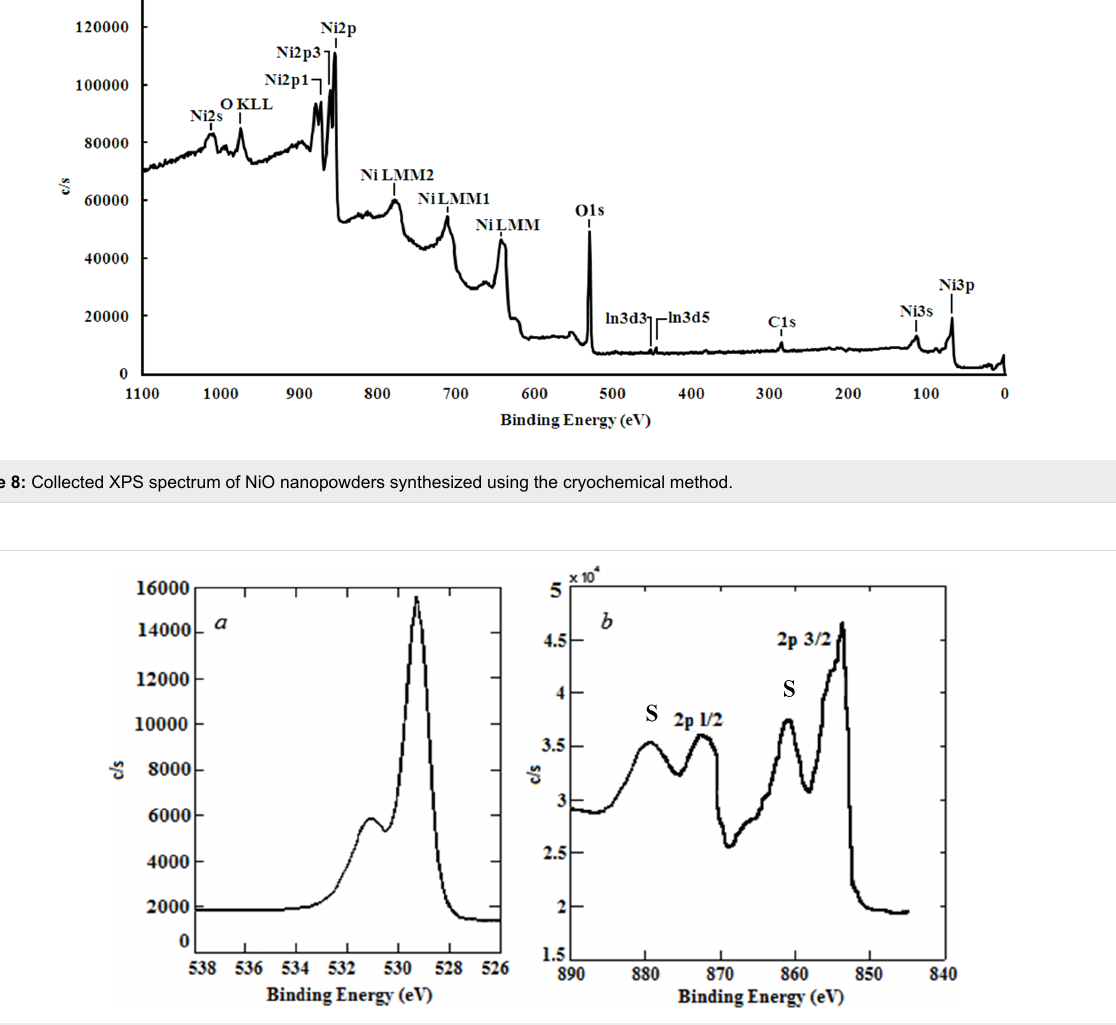
Figure 9: XPS data for NiO nanopowders synthesized using the cryochemical method: main O 1s peak is associated with structural oxygen (a) and the Ni 2p peak, containing its characteristic satellite peaks denoted by the letter S is given in (b).